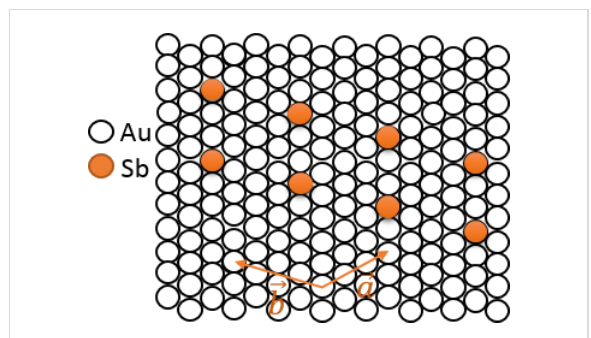
Figure 6: Tentative model of the Sb adlayer structure on Au(111) in the direction of the rows (direction of vector = (3,1), cf. Figure 5b)). White circles: Au atoms; yellow circles: Sb atoms. Only atoms that are “visible” by STM are shown, as discussed in the text, and the number of adsorbed Sb atoms is probably four times higher. A second row is also indicated assuming approximately a vector of = 0.4, where its position with repect to the first one is speculative and only approxi-